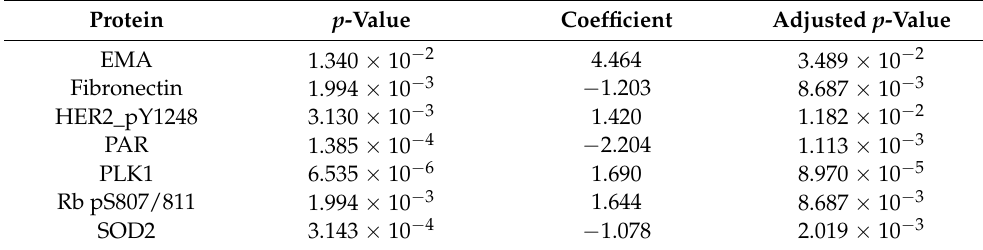
Table 2. Protein levels and their correlation with ONC201 (cid:48) s therapeutic effects. Protein p -Value Coefficient Adjusted p -Value EMA